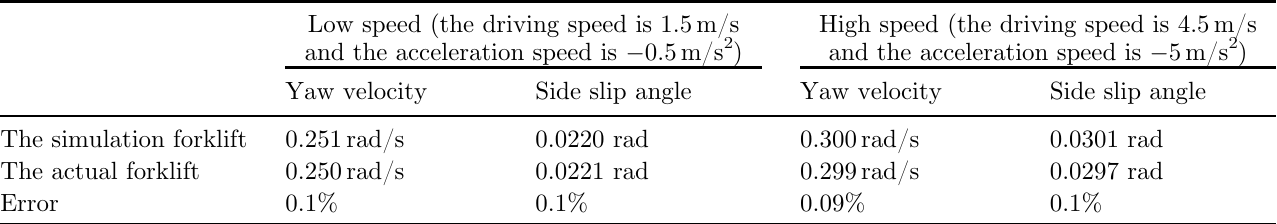
Table 2. The comparison of the steering data between the simulation forklift and actual forklift. Low speed (the driving speed is 1.5